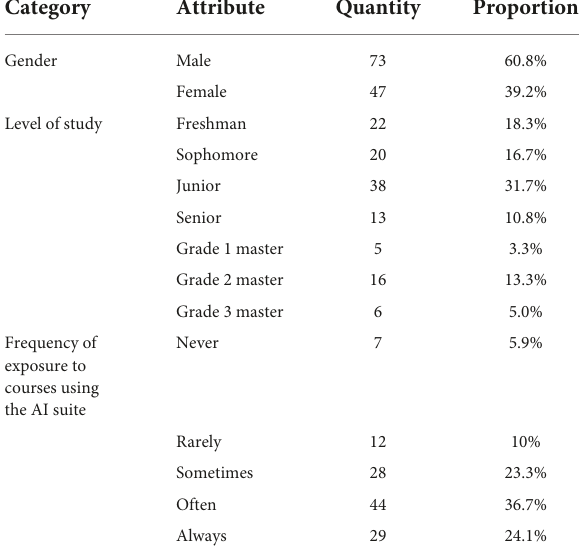
TABLE 2 Respondents’ demographic